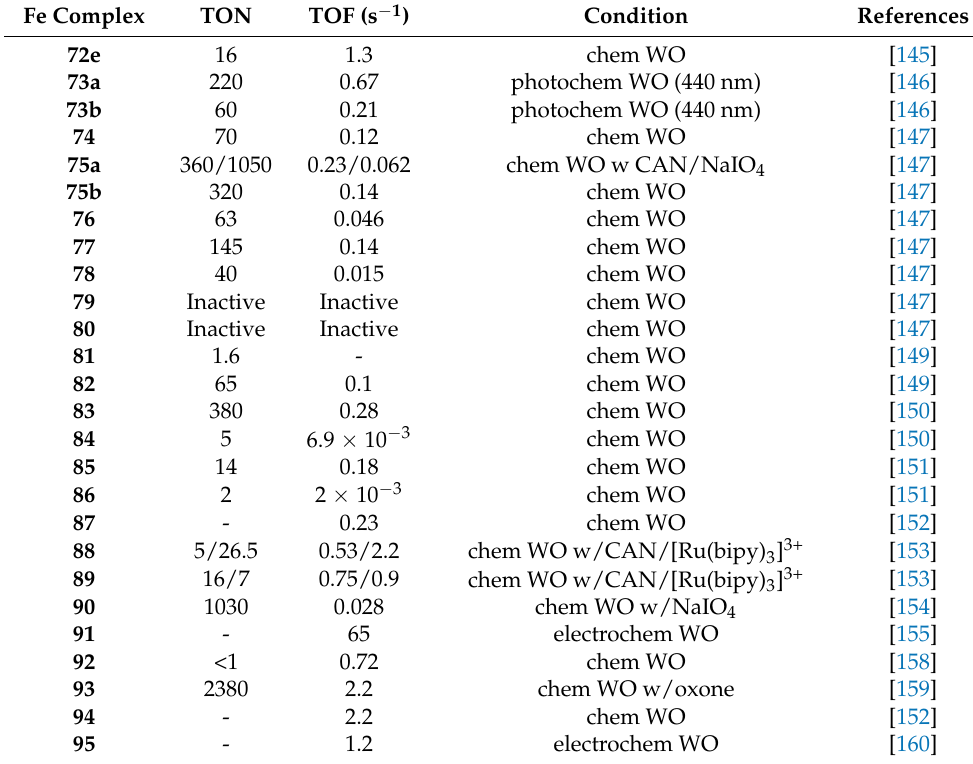
Table 6. Selected catalytic parameters and experimental conditions for Fe catalysts 72–95 in water ox- idation. Photochemical, electrochemical and chemical water oxidation are abbreviated as ‘photochem WO’, ‘electrochem WO’ and ‘chem WO’, respectively. Unless otherwise mentioned, chemical WO was carried out with CAN. The TON or TOF values that are not listed in this table are unavailable in literature. The irradiation wavelength for photochemical WO is in